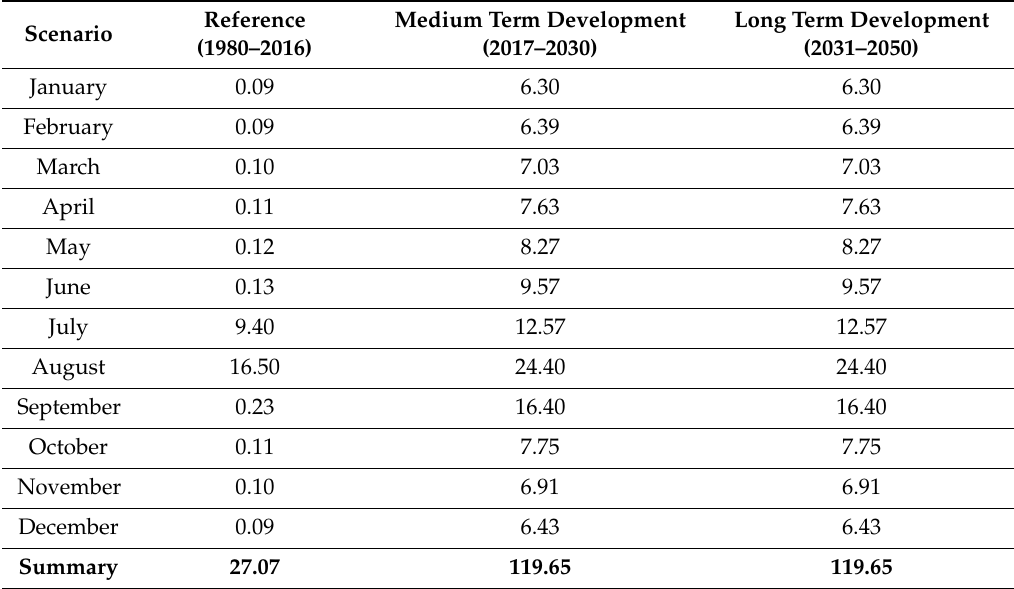
Table 3. Temporal occurrence of unmet demand across the basin